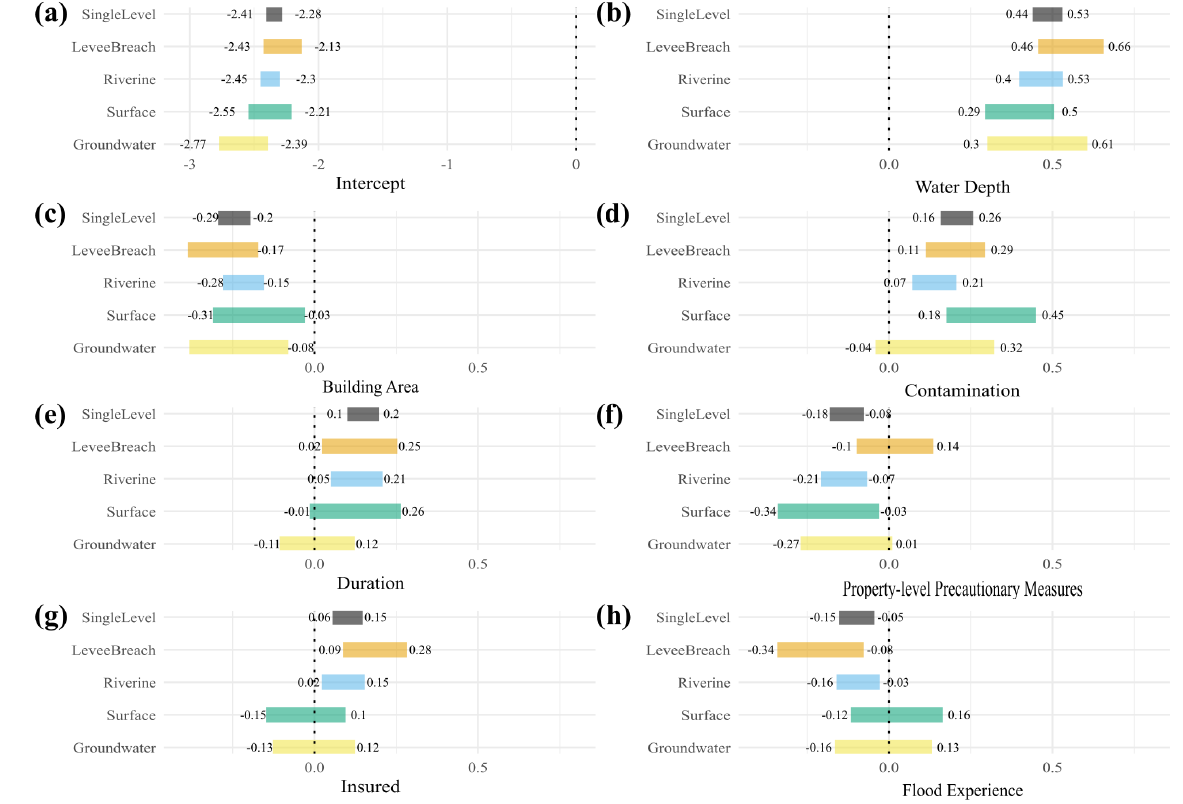
Figure 3. The 95% HDI of regression estimates of the flood-type model (across four flood types; coloured segments) and the single-level model (black segments). The intercept is the sum of the population-level effect (common across levels) and group-level effects (for each flood